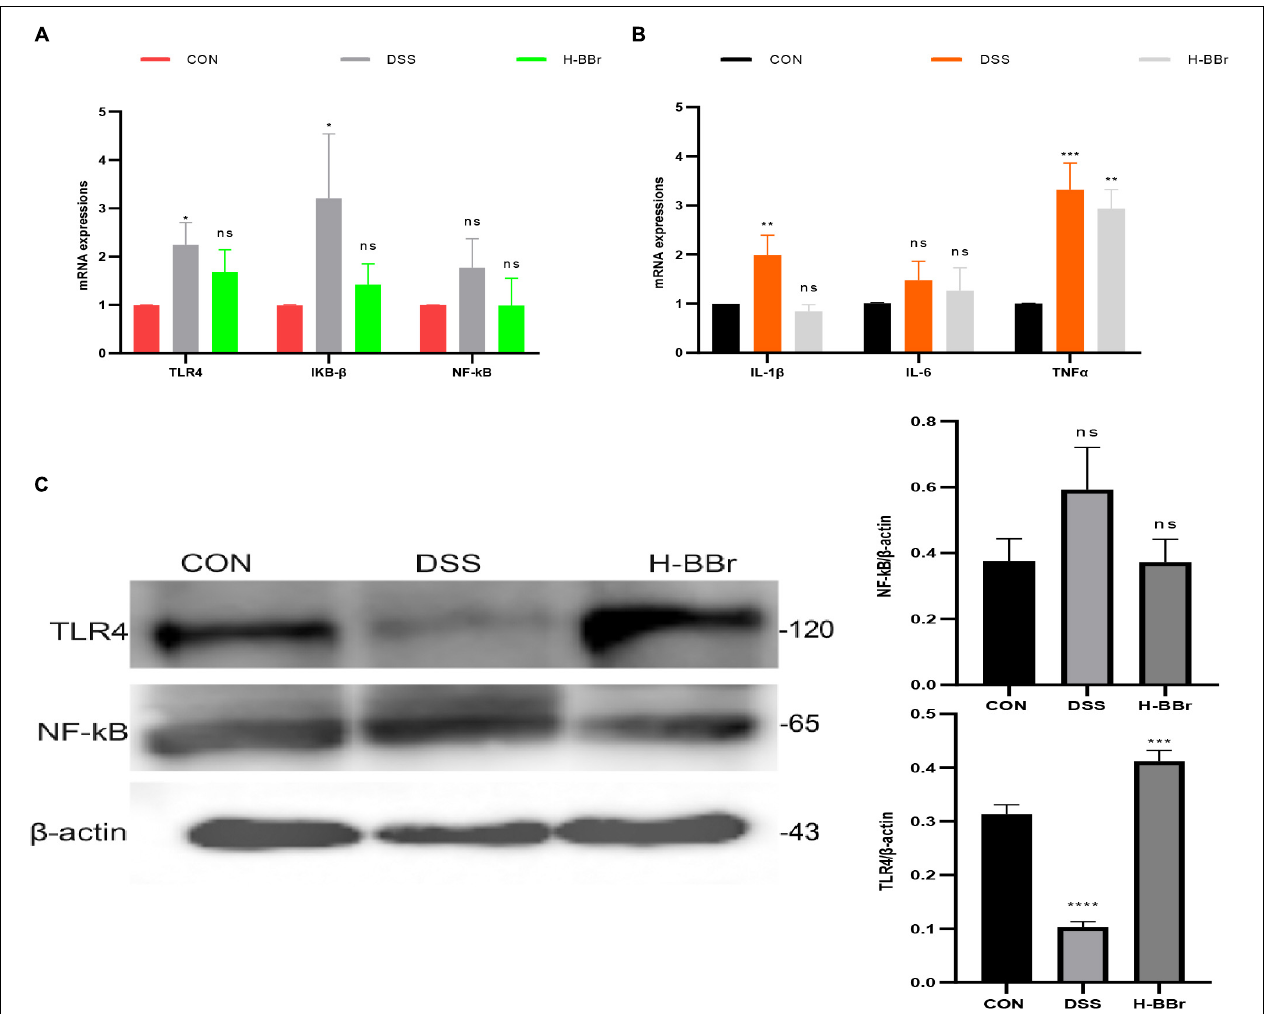
FIGURE 6 | BBr reduces the expression of inflammatory signaling. mRNA expressions of TLR4/NF-kB signaling (A) and inflammatory factor (IL-1 β , TNF α , and IL-6; B) . (C) Protein expressions of TLR4/NF-kB signaling pathway. Data represent the mean ± SD . P < 0.05 was considered statistically significant. * P < 0.05, ** P < 0.01, *** P < 0.001, and **** P < 0.0001 vs. CON